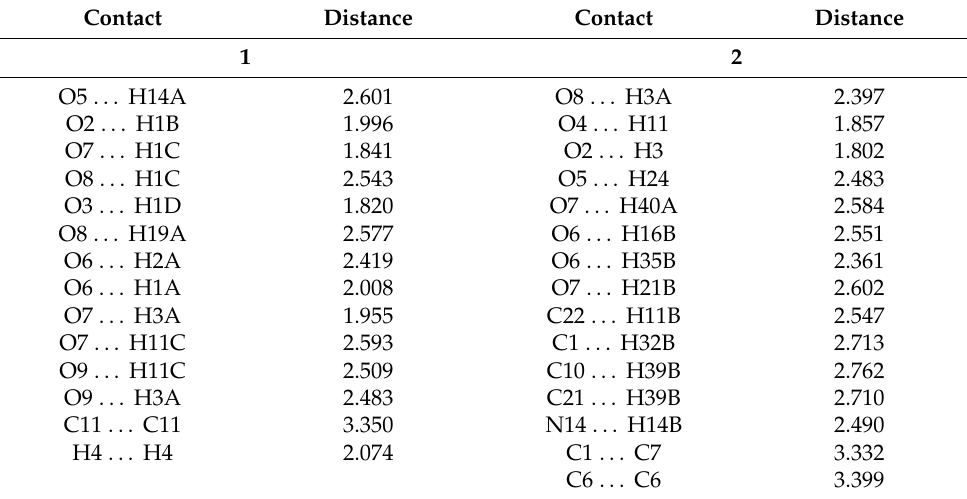
Table 4. The short-distance interactions and their distances.